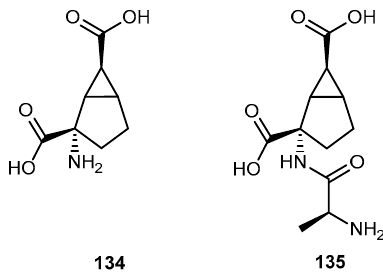
Figure 54. Chemical structures of LY354740 ( 134 ) and its amino acid prodrug LY544344 ( 135 ).